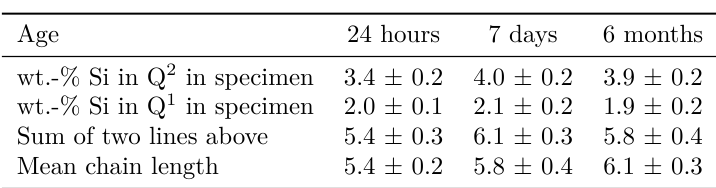
Table 1. Plausibility tests with fully hydrated activated alite.